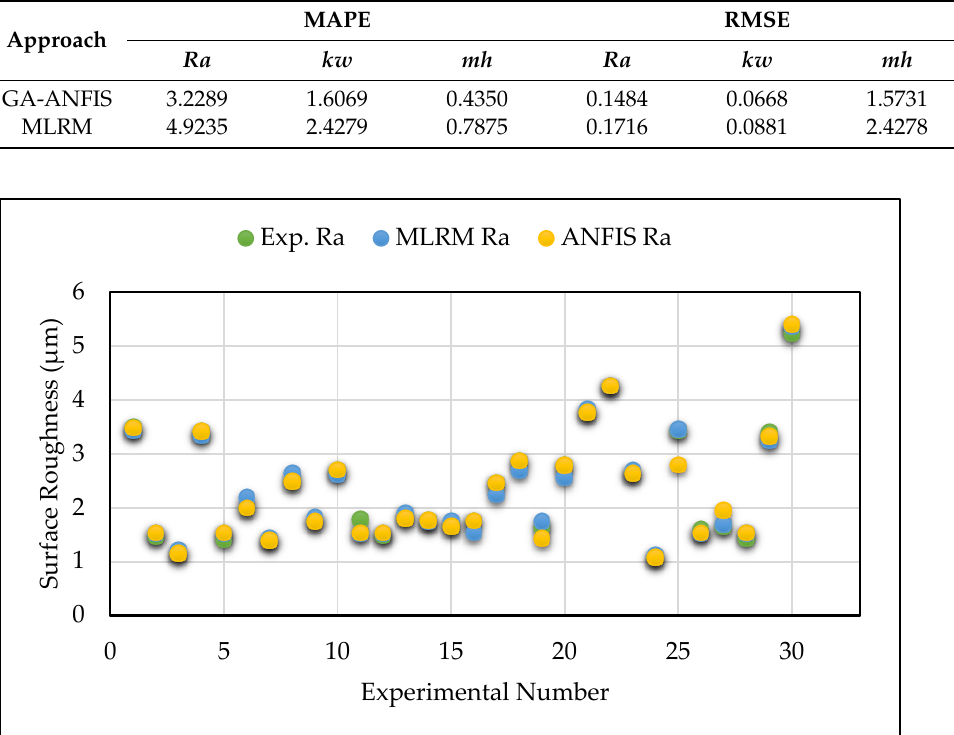
Figure 10. Comparison of ANFIS and MLRM predicted vs. experimentally measured micro hard- ness values. 4.3. Influence of PAC Parameters on Selected Responses The influence of PAC parameters on the selected response characteristics were eval- uated with the aid of ANFIS three-dimensional surface plots. From the surface plots, two parameters were varied for investigation, while the other two parameter values were kept at middle levels. The impact of PAC control factors on Ra is described with the assistance of three-dimensional plots (Figure 11a,b). The interaction dominance of CS and GP on the Ra is depicted in Figure 11a. The plot indicates that the Ra is increasing with the increase in CS from 2200 mm/min to 2600 mm/min, whereas the Ra is linearly decreasing with the increase in GP. As CS increases, the arc coherence of the plasma will be deviated from its axis, resulting in an enlarged kerf and simultaneous reduction in surface quality [59]. Therefore, the Ra increases with an increasing of CS. It can be seen that the higher GP results in a smooth cut surface with minimized roughness values. As the GP increases, the